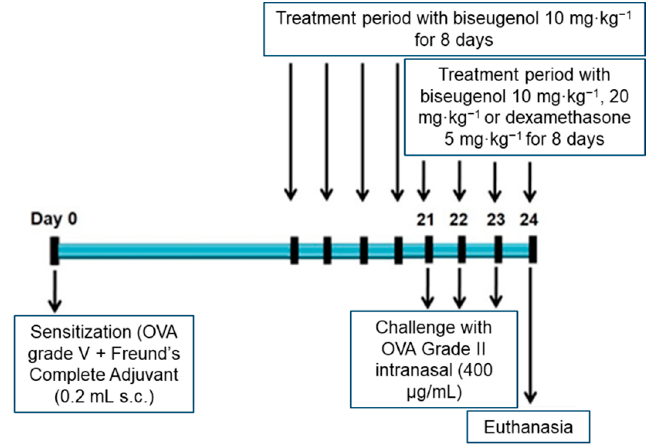
Figure 6. Experimental protocol for the induction of mixed-granulocytic asthma and active treatment period. OVA: ovalbumin.